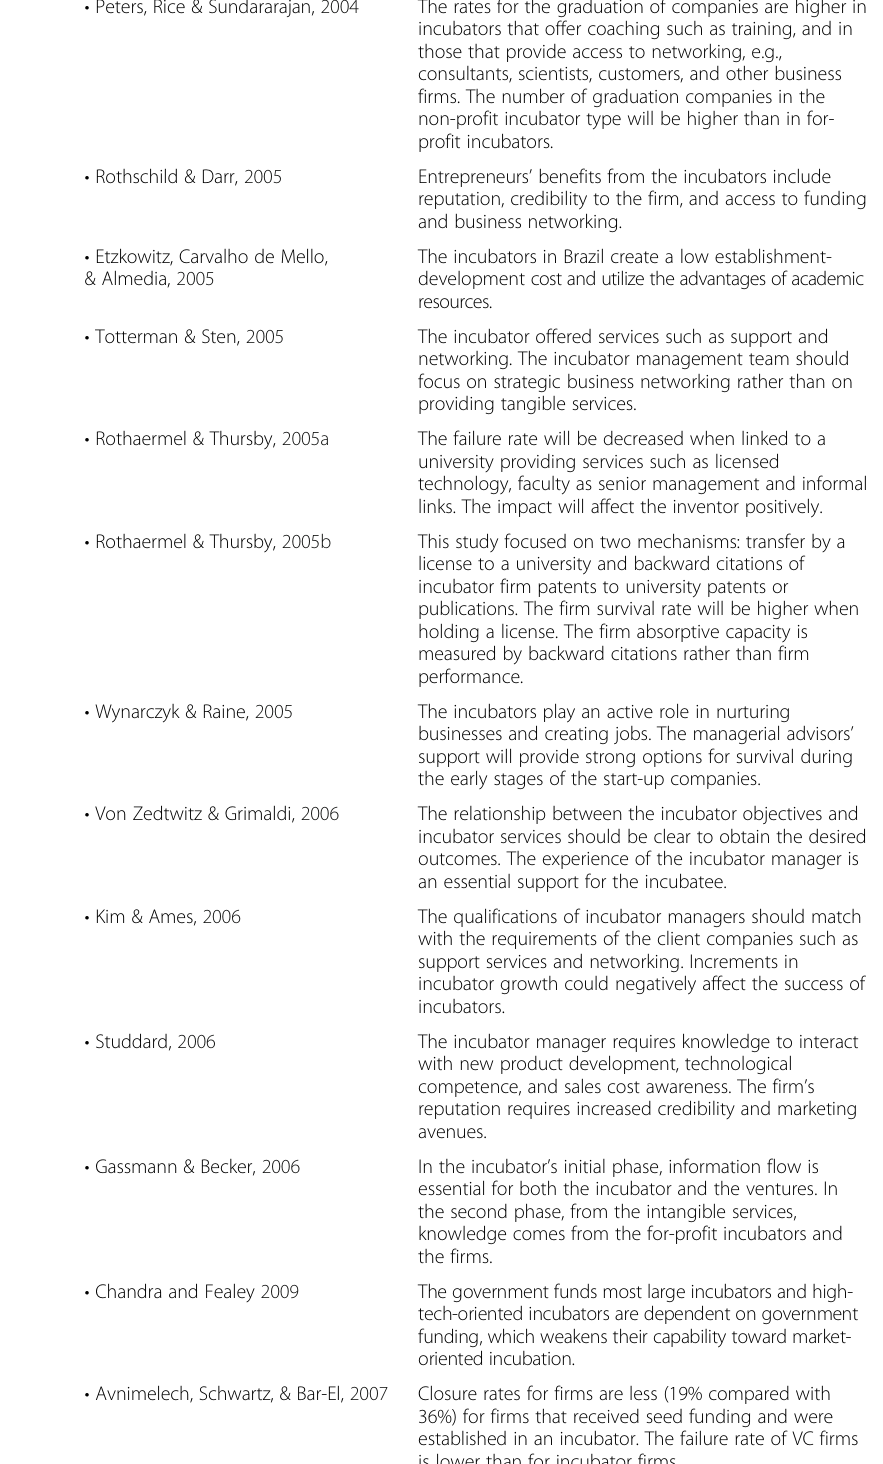
Table 1 Incubators: evidence from the literature